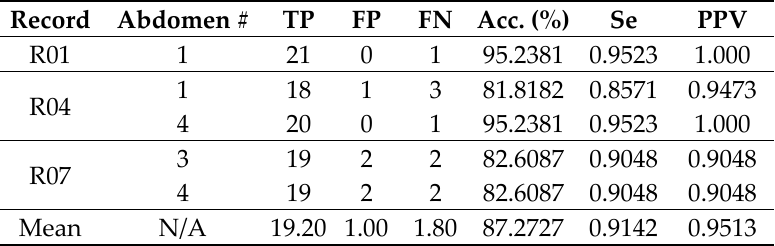
Figure 4. FQRS complexes also detected as MQRS complexes wrongly. Table 1. Accuracy table of the results obtained when compared to the reference fetal scalp